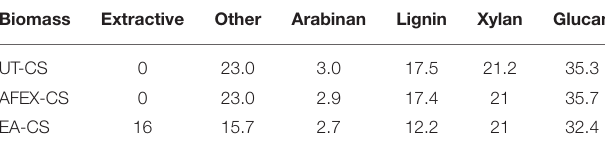
TABLE 2 | Composition of untreated and pretreated corn